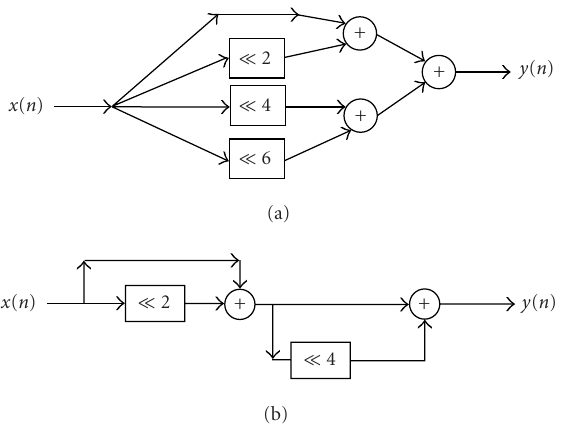
Figure 4: Implementation of a constant coe ffi cient multiplier of value 85 using (a) CSD coding and (b) subexpression